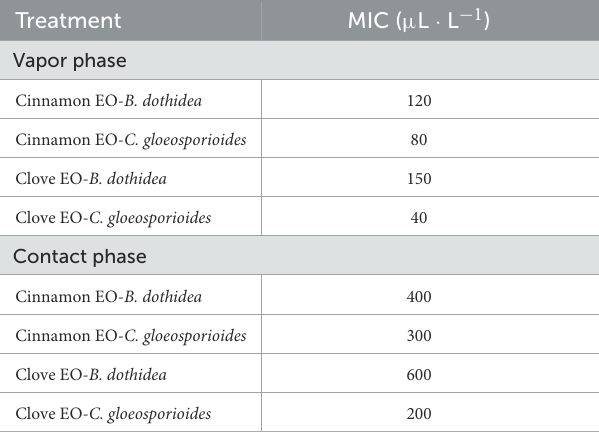
TABLE 4 MIC values of cinnamon and clove EO on B. dothidea and C. gloeosporioides .